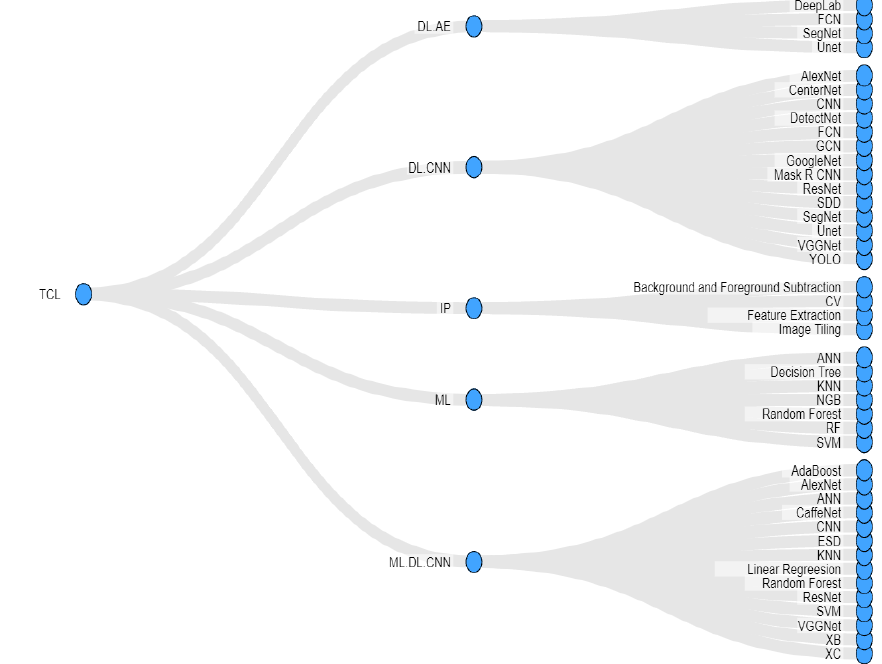
Figure 12. The distribution of different algorithms with respect to five thematic classification labels